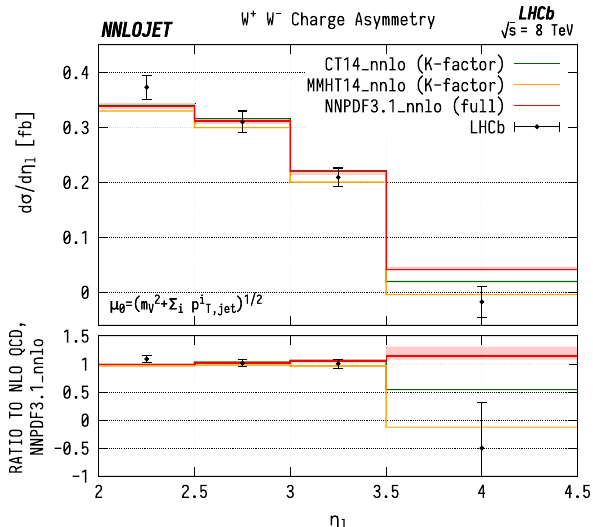
Fig. 13 W ± asymmetry in WJ final states differential in the pseudora- pidity η of the lepton produced from the W boson decay, evaluated with NNPDF3.1 (red), MMHT14 (yellow), CT14 (green) NNLO parton dis- tribution functions. The NNPDF3.1 curve corresponds to a full NNLO calculation with scale uncertainties as described in the main text, and is used to determine a differential NNLO/NLO K-factor. The other two predictions are calculated at NLO and then rescaled by this K-factor